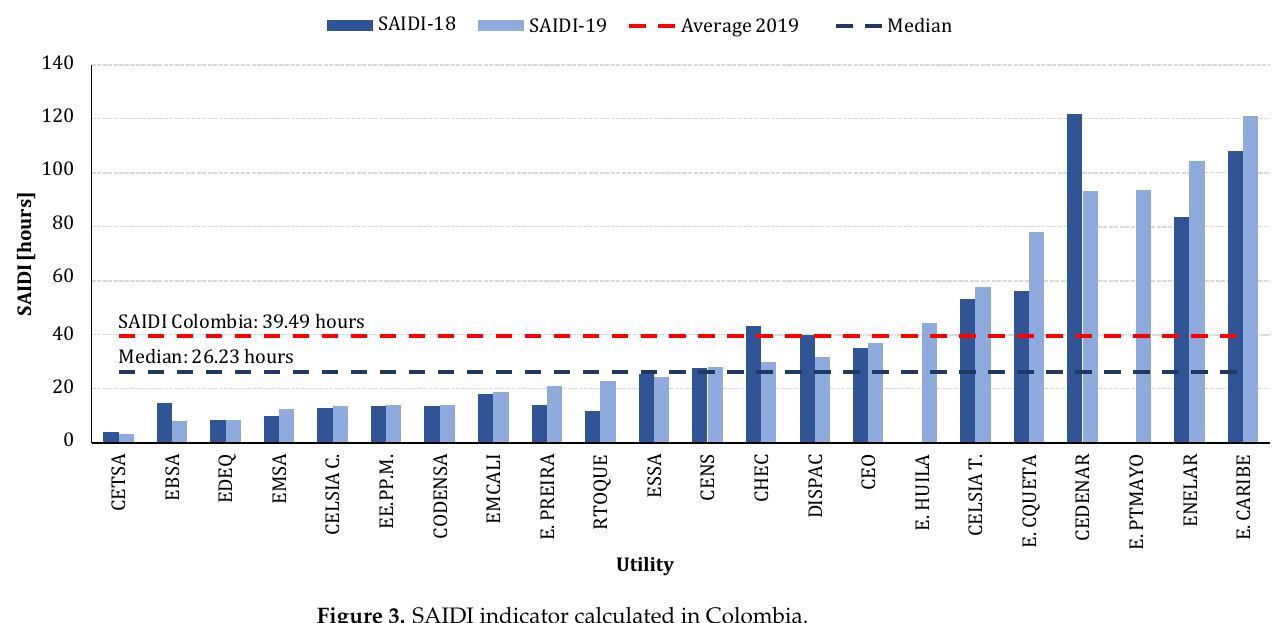
Figure 3. SAIDI indicator calculated in Colombia.